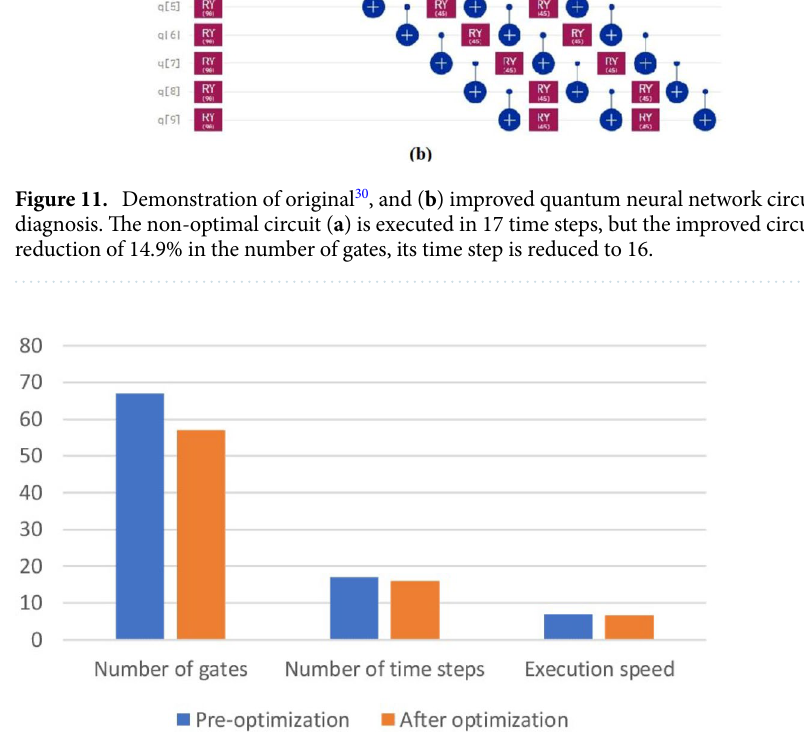
Figure 12. Comparison between optimized and non-optimized quantum neural networks